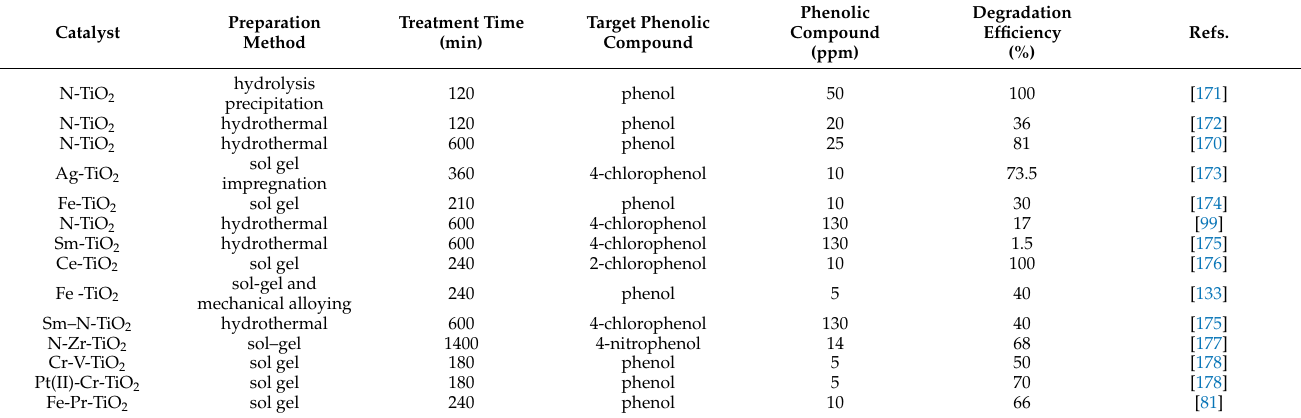
Table 4. List of doped and codoped catalysts used on visible light degradation of phenolic